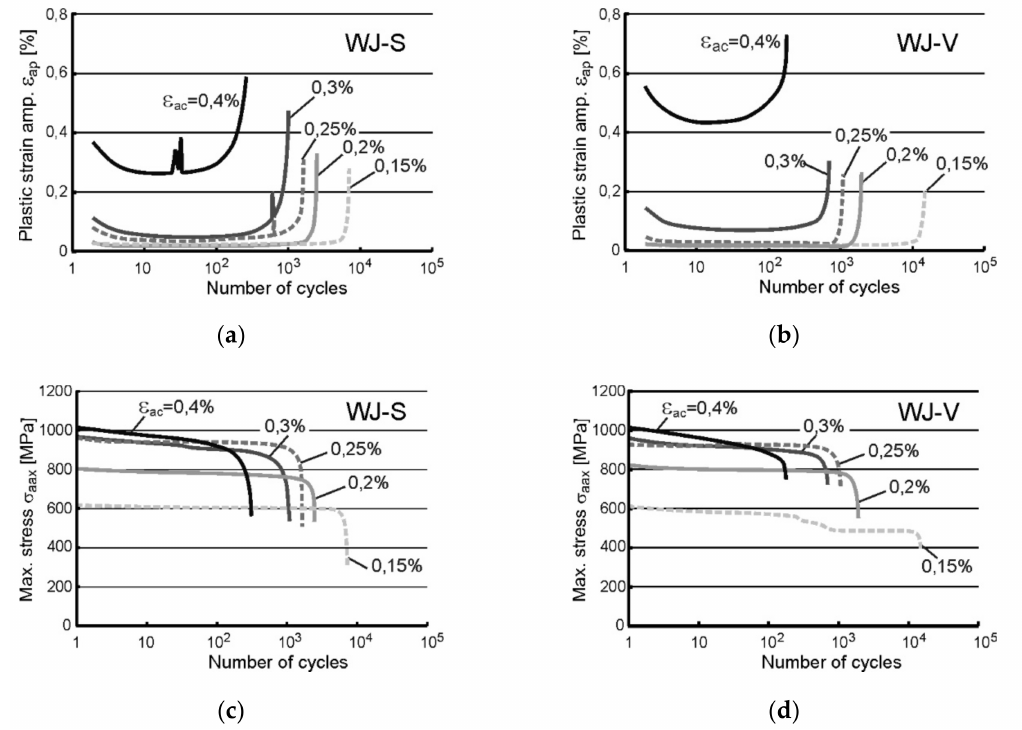
Figure 4. The results of LCF tests recorded for WJ as the courses of: ( a ) ε ap recorded for WJ-S; ( b ) ε ap recorded for WJ-V; ( c ) σ max recorded for WJ-S; ( d ) σ max recorded for